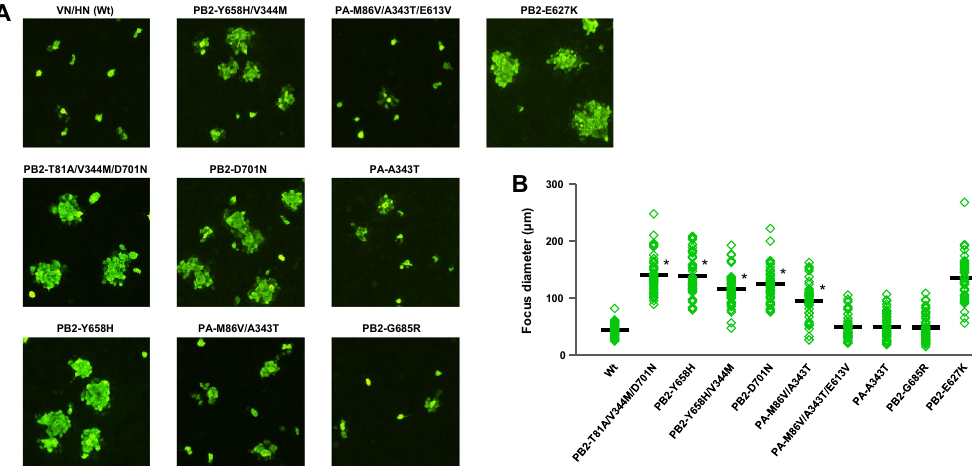
Figure 4. Effect of H5N1 polymerase mutations on foci sizes. ( A ) MDCK cells (90% confluent in 96-well plates) were infected with 100 FFU of the indicated VN/HN viruses. After 48 h incubation at 37 °C, foci sizes were measured by fluorescence microscopy. ( B ) Foci sizes are shown as the average diameter from three separate experiments, with each focus diameter shown as an open diamond. An asterisk indicates a P value < 0.01 (ANOVA with Tukey’s multiple comparison